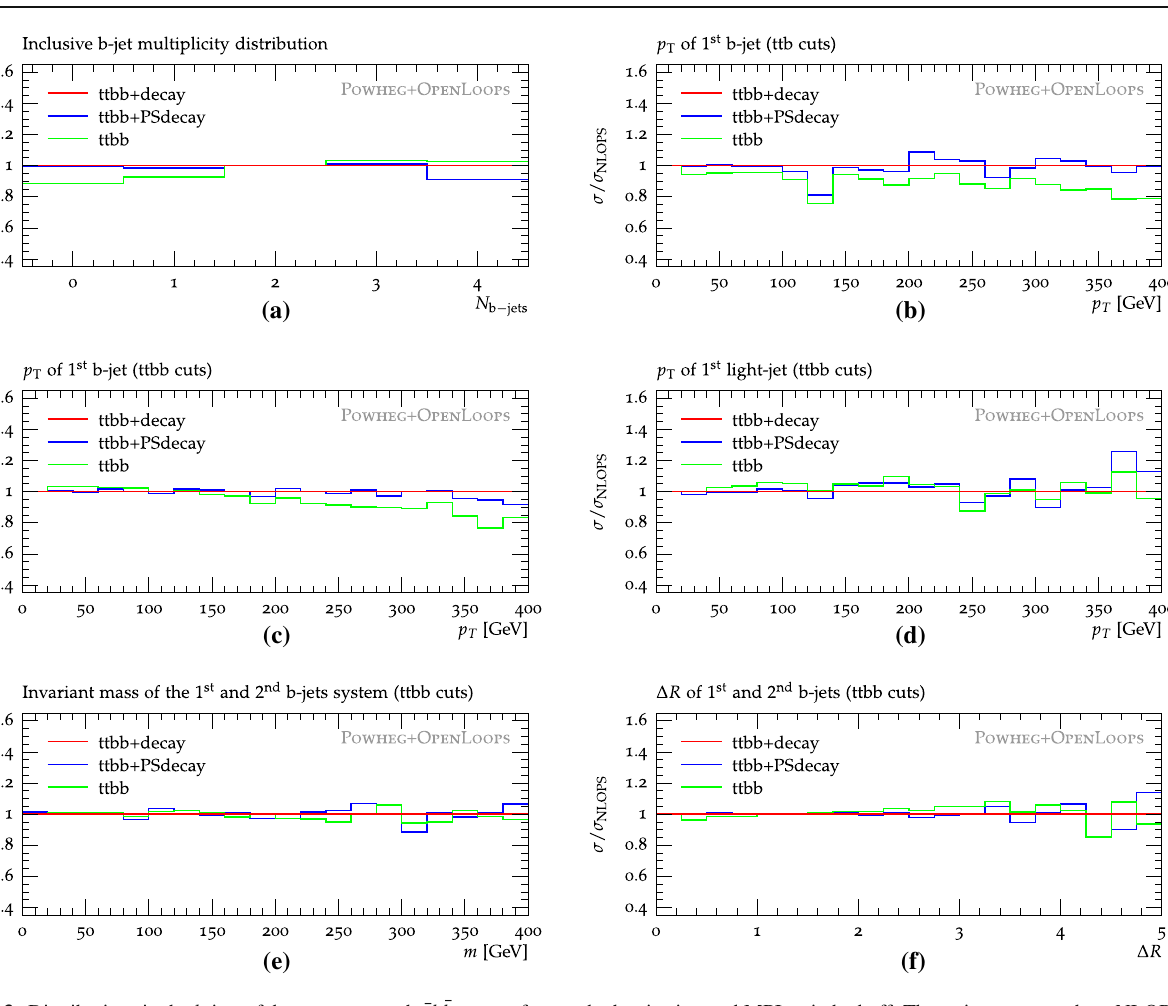
Fig. 13 Distributions in the b -jets of the reconstructed t ¯ tb ¯ b system for hadronisation and MPI switched off. The ratio corresponds to NLOPS √ pp → t ¯ t + b -jets with dileptonic top decays at s =13TeV. Inclusive predictions with Pythia decays (ttbb+PSdecay) or stable top quarks (ttbb) normalised to corresponding ones with spin-correlated decays number of additional b -jets ( a ), distribution withttbcuts inthe p T of the (ttbb+decay). Top-decay products are subject to acceptance cuts, while first b -jet (b) and distributions with ttbb cuts in the p T of the first b -jet predictions with stable top quarks are normalised to ttbb+decay ones at ( c ) and light-jet ( d ) as well as in the invariant mass ( e ) and Δ R ( f ) of the the level of the ttbb cross first and second b -jet. All results are based on Powheg+Pythia with